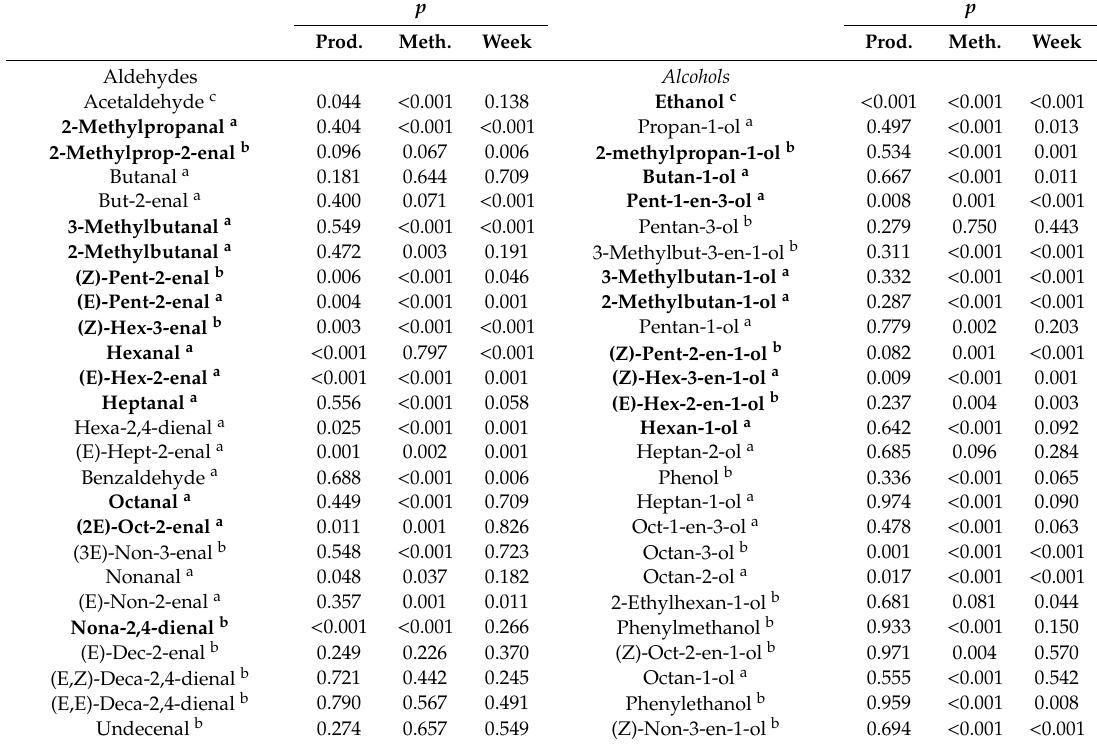
Table 2. Significance levels from a three-way ANOVA performed on the volatile compounds data * from the oil extracted from Verdial de Badajoz fruits farmed organically or conventionally (Prod.) and collected from the threes or from the ground (Meth.) over a six-week period (Week). p p Prod. Meth. Week Prod.